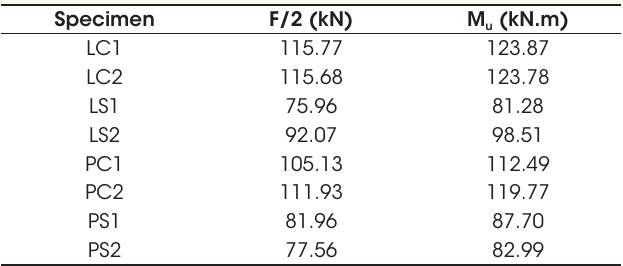
Maximum applied loads and ultimate moment (flexural strength) of the connections Specimen